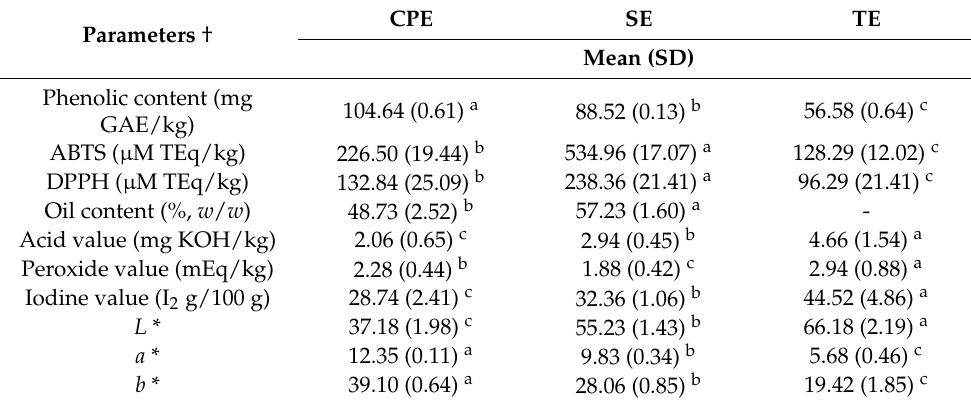
Table 1. Physicochemical composition of shea